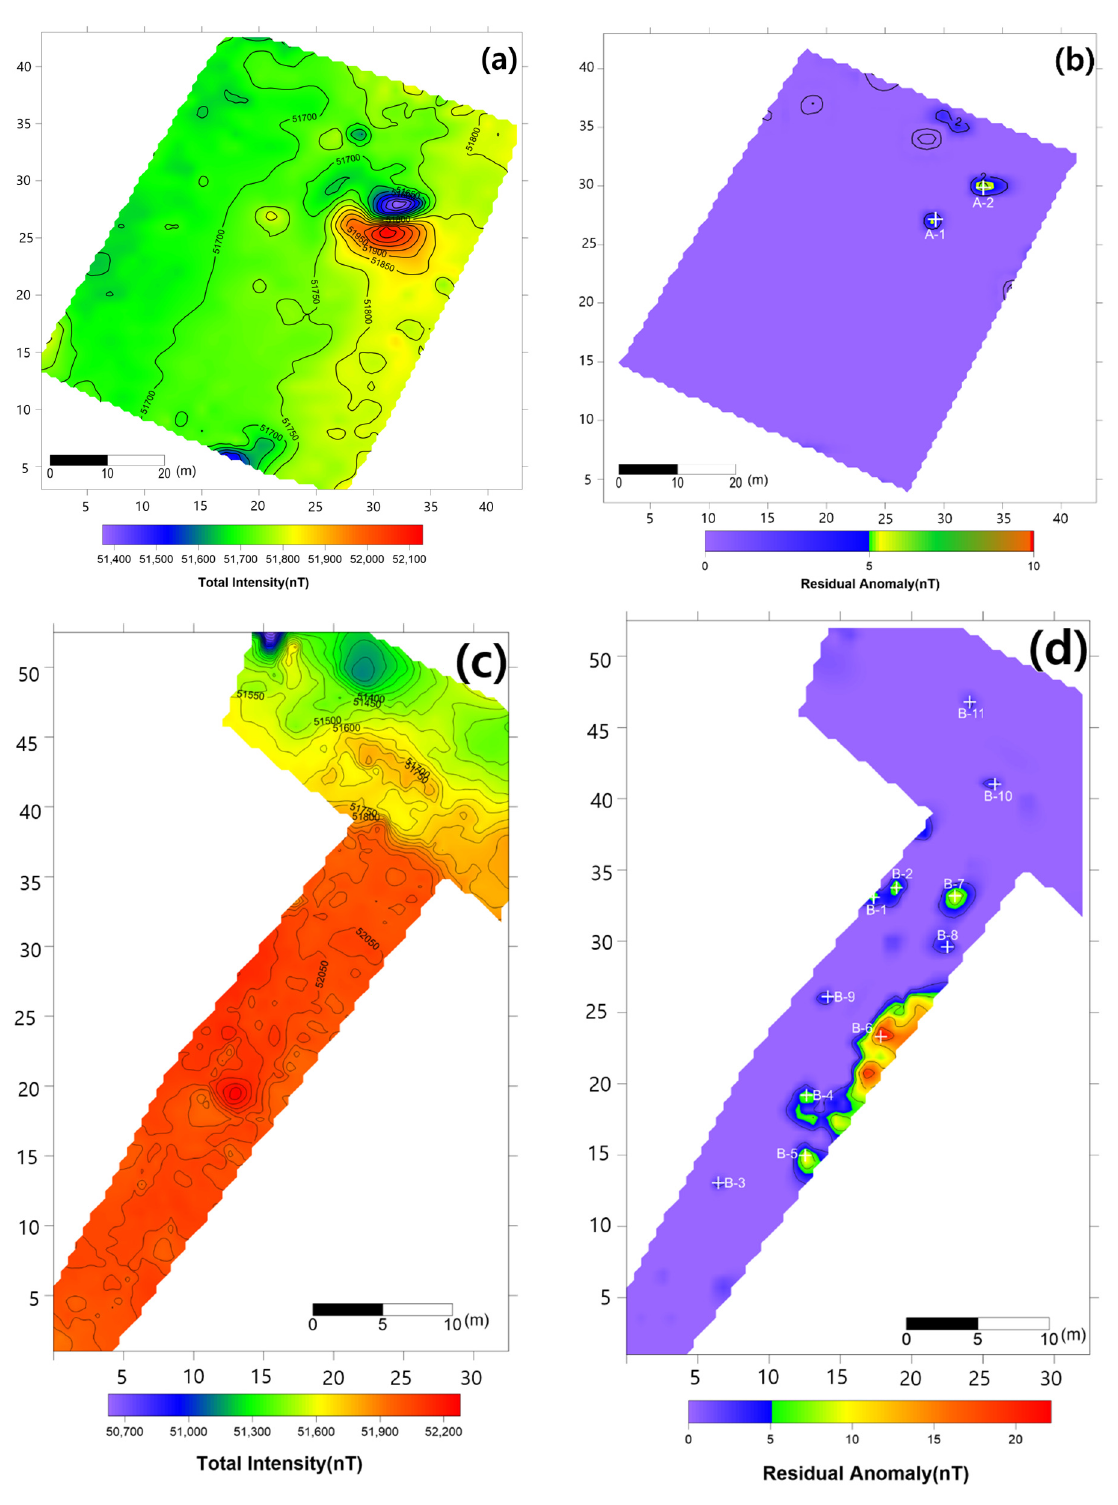
Figure 8. Results of the magnetic survey. ( a ) Total intensity map of Area A; ( b ) map of Area A after application of the proposed data-processing method; ( c ) total intensity map of Area B; ( d ) map of Area B after application of the proposed data-processing method.